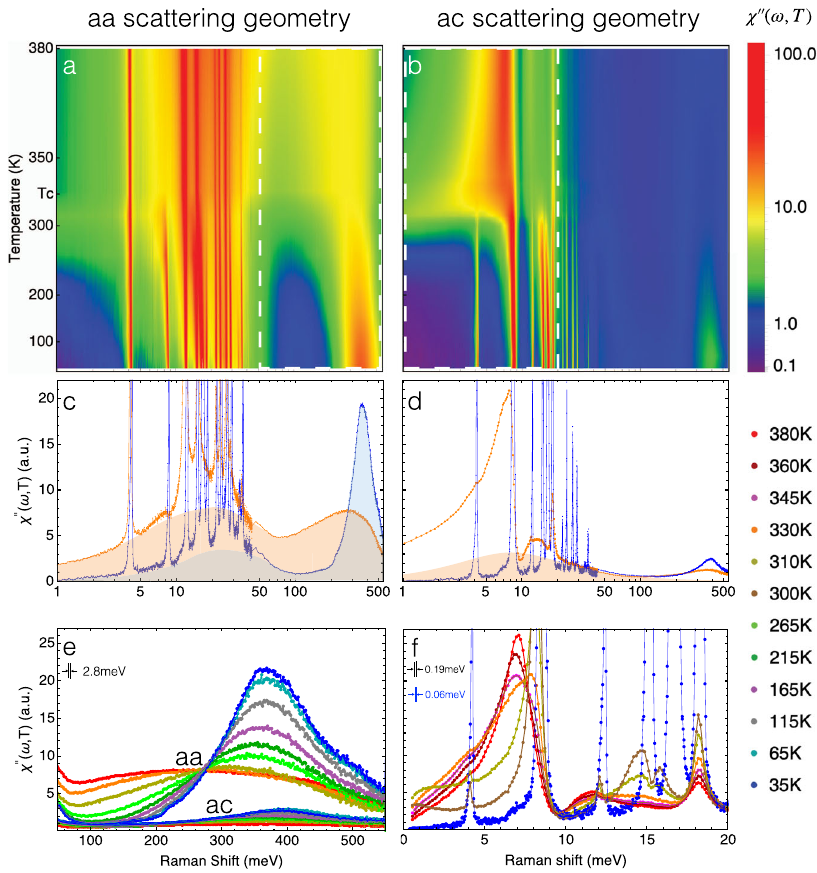
Fig. 2 Temperature dependence of Raman spectra. a and b Raman response χ 00 and χ 00 in the aa and ac scattering geometries, respectively. aa ac The horizontal frequency (Raman shift) scales are logarithmic. To emphasize the region around T c = 328 K the vertical axes are rescaled by a nonlinear transformation arctanh [ T / T 0 ], where T 0 = 390 K. χ ″ values are displayed on a logarithmic false color scale, with the strongest phononic resonances in saturation. In b , a critical enhancement at low frequencies is observed close to T c . Owing to broken mirror symmetries below T c , “ leakages ” of sharp phonon features appear in both ( a and b ). Additionally, a strong peak at 380 meV emerges in ( a ) with a weaker and χ 00 , for T = 330 K (above T c ) and T = 35 K. Shading highlights the electronic feature in ( b ). c and d Details of Raman response χ 00 aa ac contribution (see also Fig. 3). e and f χ 00 and χ 00 in the range enclosed by the dashed white boxes in ( a and b ) on a linear frequency scale with aa ac ð ω ; T Þ all cross at the 280 meV isosbestic point, showing intensity transfer on heating from the the resolution shown in top left corner. In e , χ 00 aa ð ω ; T Þ is shown for intensity comparison. In f , above T 380 meV peak to the low-temperature gap region. χ 00 c (red curve) three phonon modes ac are observed, with the fi rst two showing a pronounced asymmetric Fano lineshape, pointing to an interaction with an electronic continuum. Below T c the asymmetry becomes less pronounced and additional modes appear due to mutual aa - ac “ leakage ”